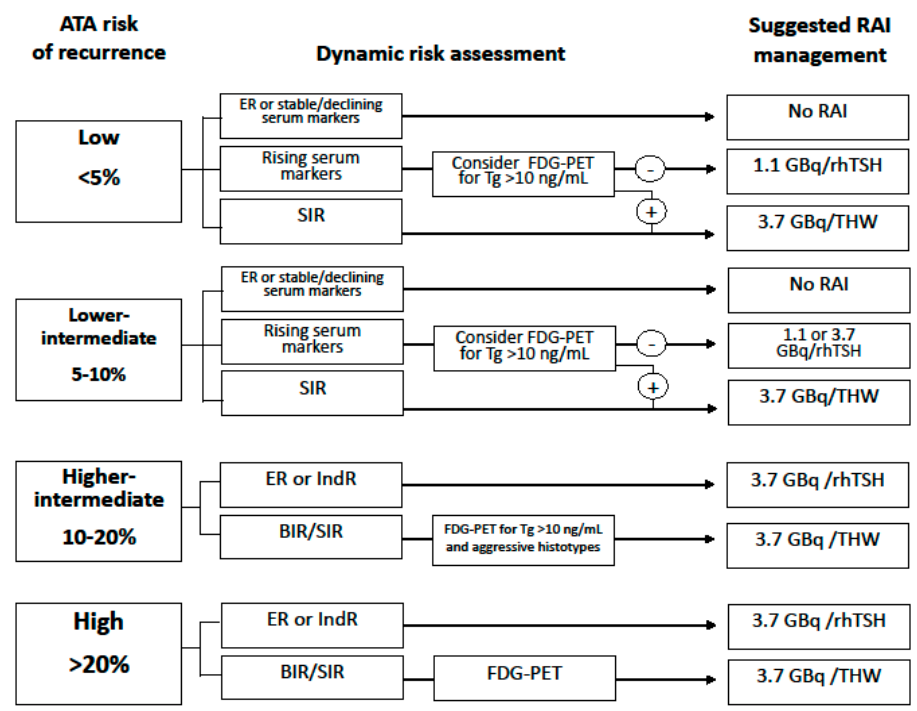
Figure 1. Indications for RAI therapy considering both dynamic risk assessment and 18 FDG-PET information. Abbreviations: RAI, radioiodine; ATA, American Thyroid Association; FDG-PET, fluorodeoxyglucose-positron emission tomography; Tg, thyroglobulin; rhTSH, human recombinant thyroid stimulating hormone; THW, thyroid hormone withdrawal; ER, excellent response; SIR, structural incomplete response; BIR, biochemical incomplete response; IndR, indeterminate response.